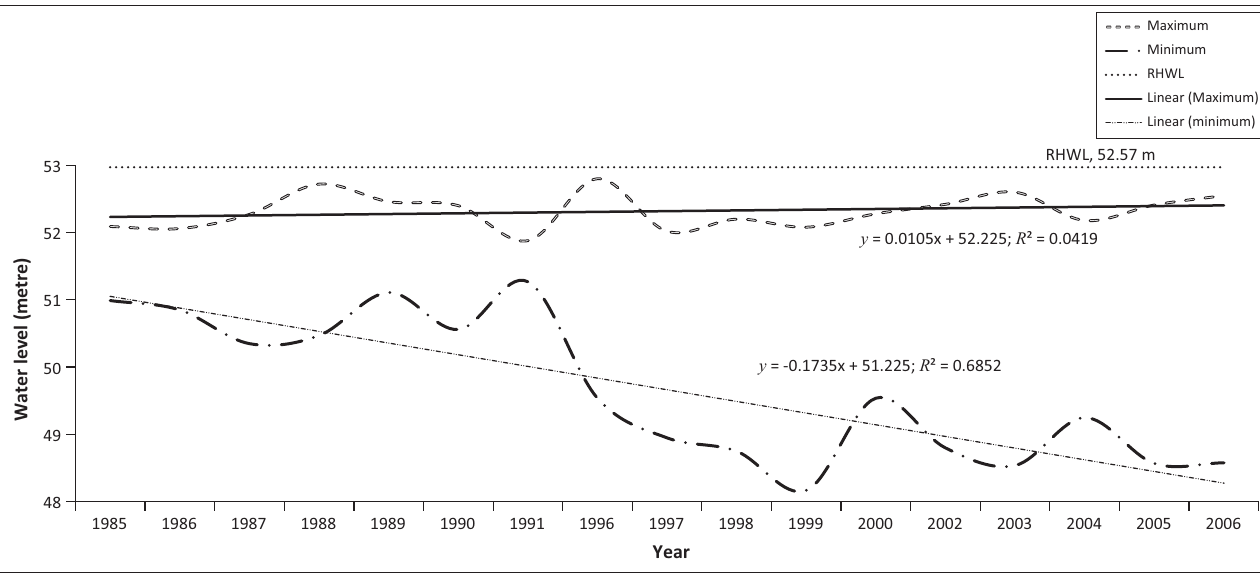
FIGURE 12: Yearly recorded minimum water level at Dalia station from 1985 to